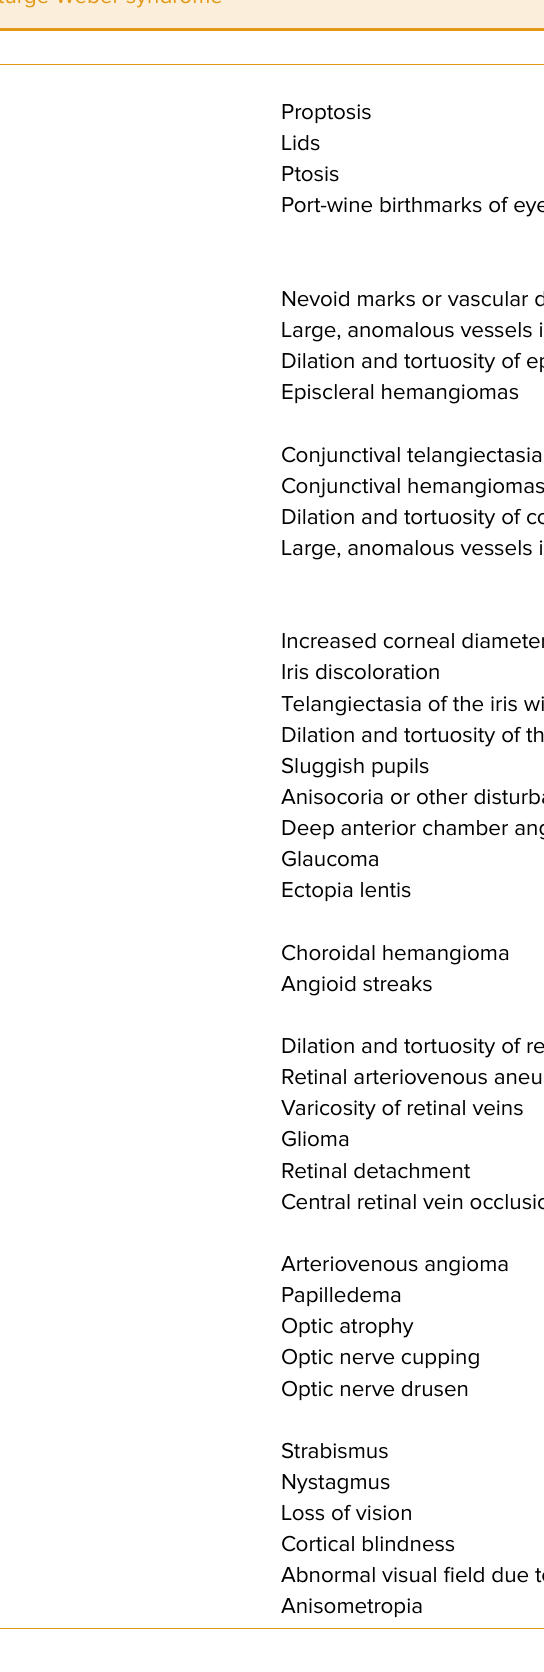
Table 1. Summary of ocular findings in Sturge-Weber syndrome